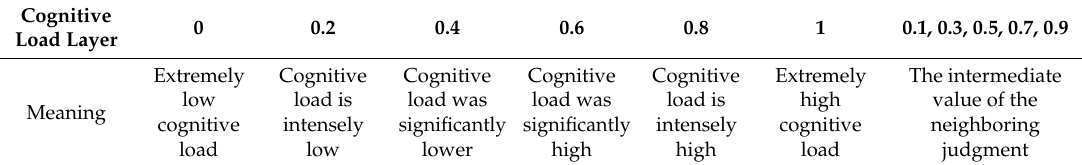
Table 3. Cognitive load rating.